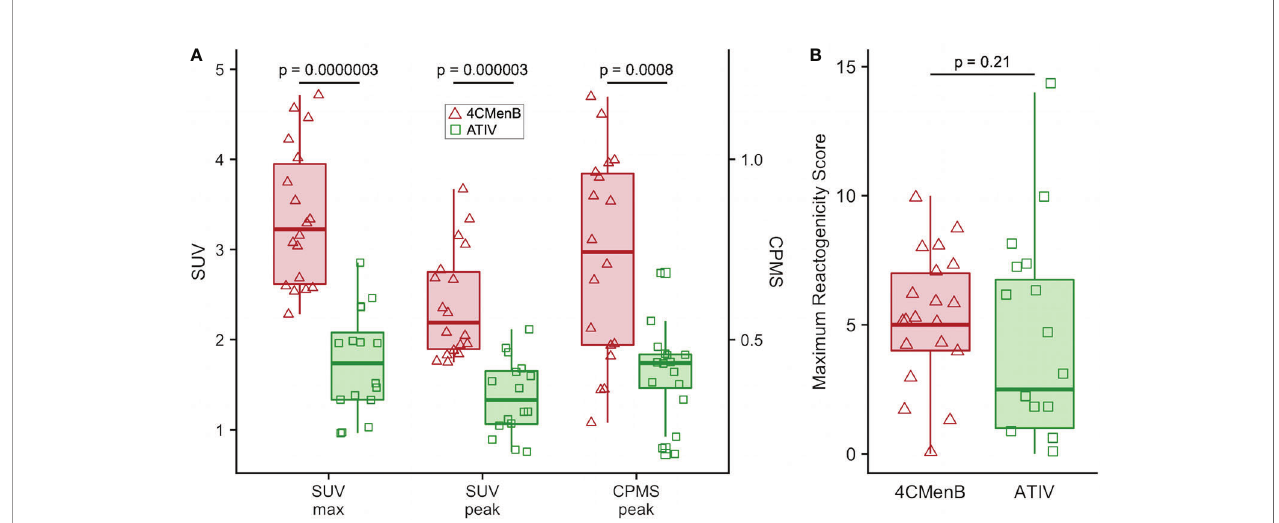
FIGURE 4 | Comparison of 4CMenB and ATIV 18 F-FDG PET/CT muscle activity and solicited symptoms severity scores. (A) SUVmax, SUVpeak and CPMS peak activity in muscle for all participants at all time points after receiving 4CMenB (pink, triangles) or ATIV (green, squares). (B) Maximum reactogenicity score on any day after immunization for all participants after receiving 4CMenB (red, triangles) or ATIV (green, squares). Horizontal bar: vaccine group median, shaded box: 95% con fi dence interval, whiskers: range. p values: Wilcoxon signed-rank test between vaccine